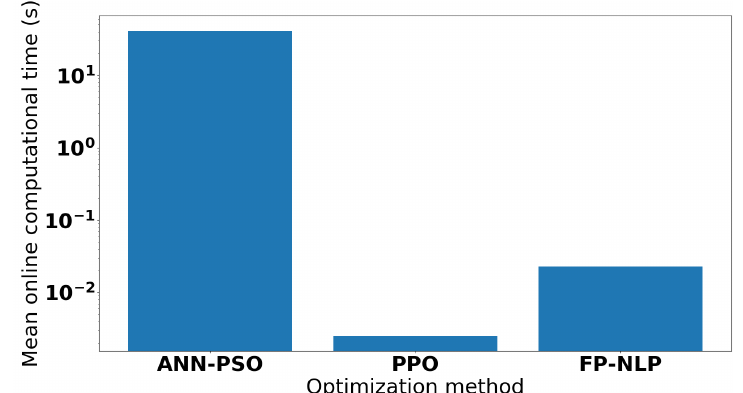
Figure 6. Online average computational times for ANN-PSO, PPO, and